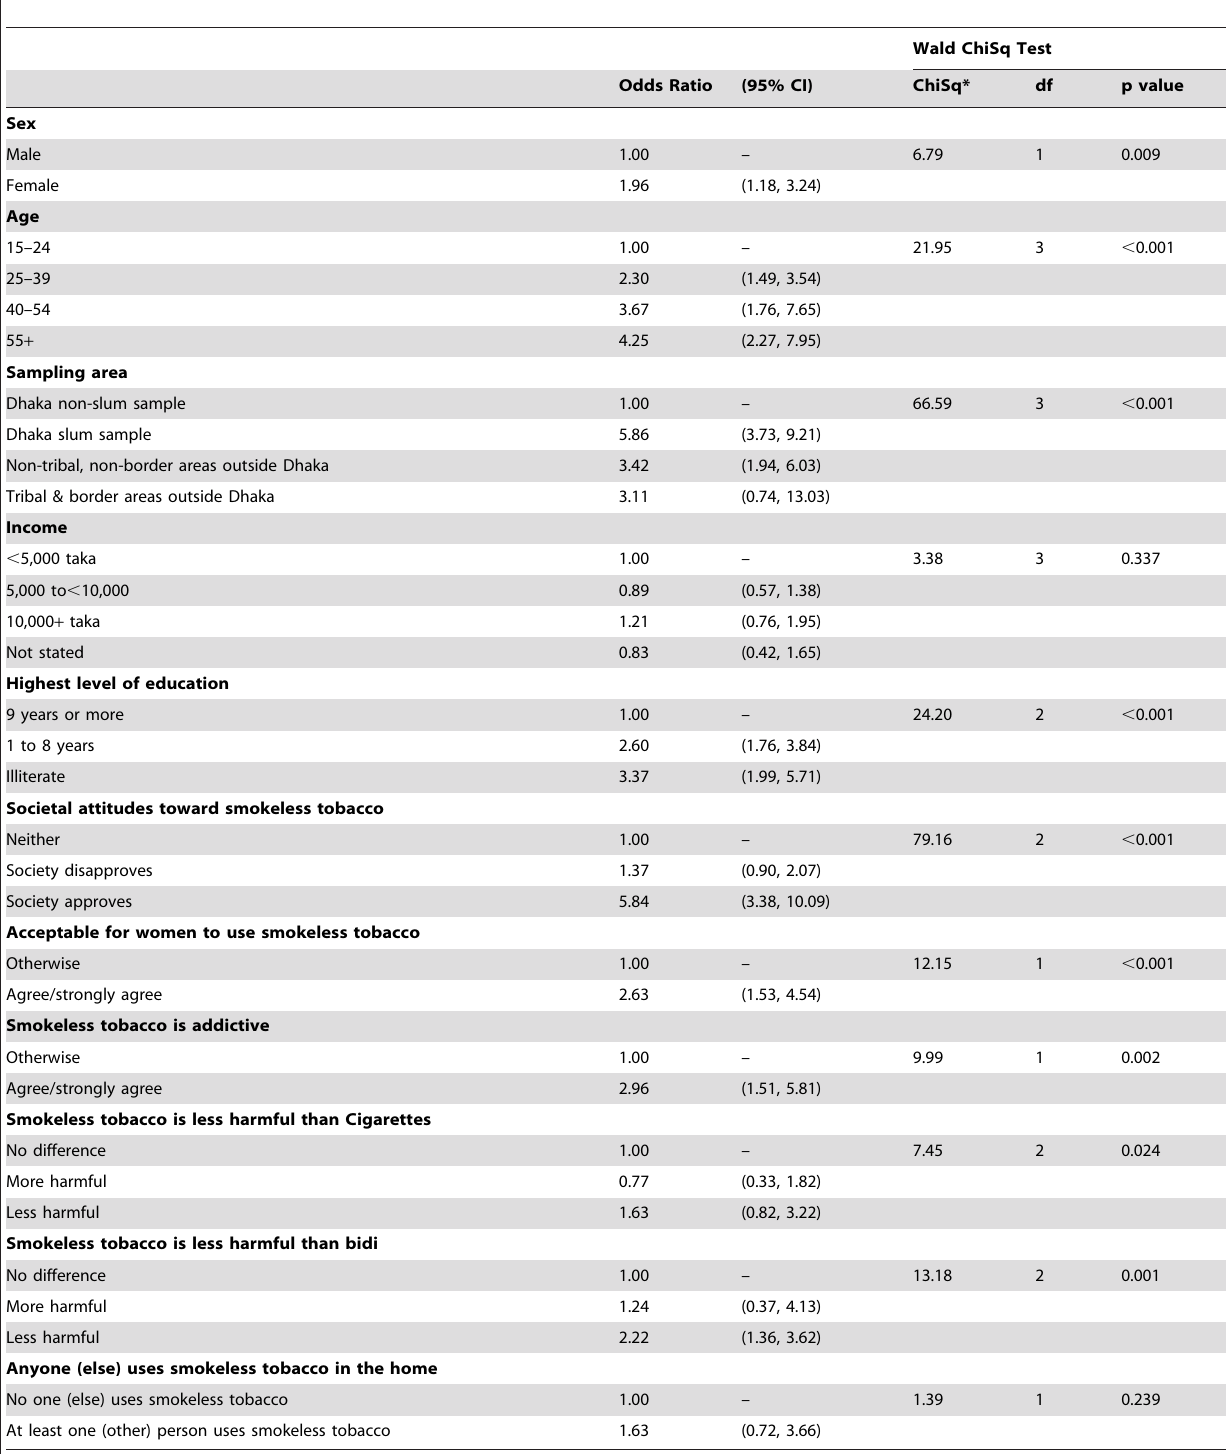
Table 4. Odds of being a current smokeless tobacco user (weighted; n =4702), Bangladesh